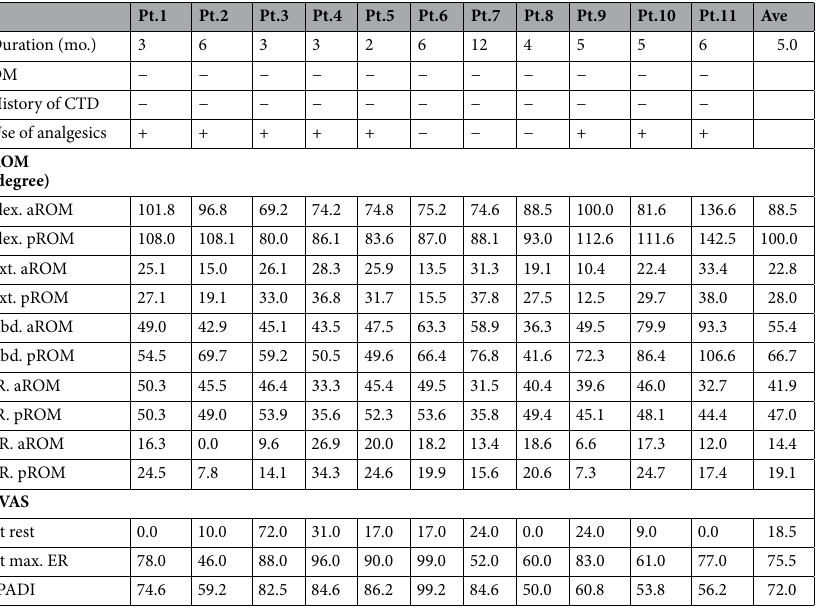
Table 1. Baseline patient characteristics. Abd, abduction; aROM, active range of motion; Ave., average; CTD, connective tissue disease; DM, diabetes mellitus; ER, external rotation; Ext, extension; Flex, flexion; IR, internal rotation; mo., month; max., maximal; pROM, passive range of motion; pVAS, pain visual analog scale; Pt, patient; SPADI, shoulder pain and disability